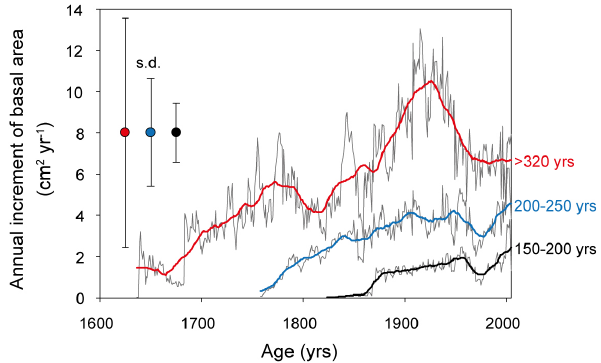
Fig. 2. Annual increment of trees as related to time before present for tree individuals older than 320yrs ( n =9), of individuals be- tween 200 and 250yrs ( n =29), and of individuals between 150 and 200yrs ( n =8). Depicted are averages of annual rates (thin black lines) and a smoothed line of running average over about 10yrs, de- pending on the number of samples (thick red line for > 320yrs, blue line for 200 to 250yrs and black line for 150 to 200yrs).